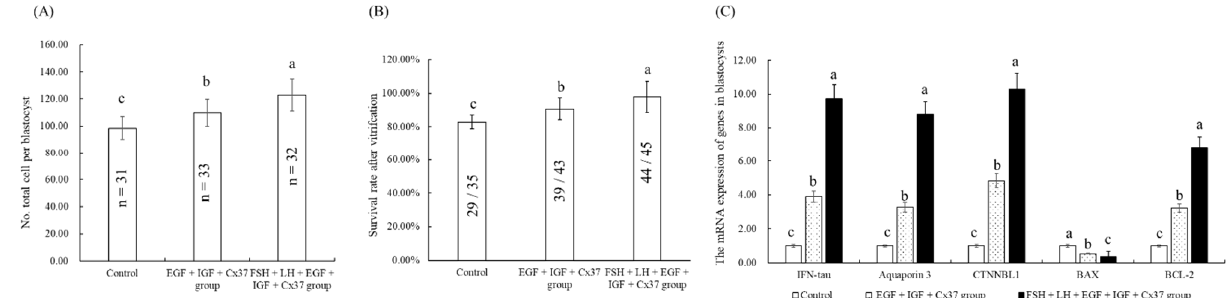
Figure 4. Effect of the combination treatment of EGF, IGF-1, and Cx37on the quality of IVF blasto- cysts. ( A ) Effect of the combination treatment of EGF, IGF-1, and Cx37 on the total cell number per blastocysts. ( B ) Effect of the combination treatment of EGF, IGF-1, and Cx37on the survival rate of blastocysts after vitrification. ( C ) Effect of the combination treatment of EGF, IGF-1, and Cx37 on the quality-related gene expression in blastocysts. a, b, c Values with different superscripts indicate significant differences between groups ( p <